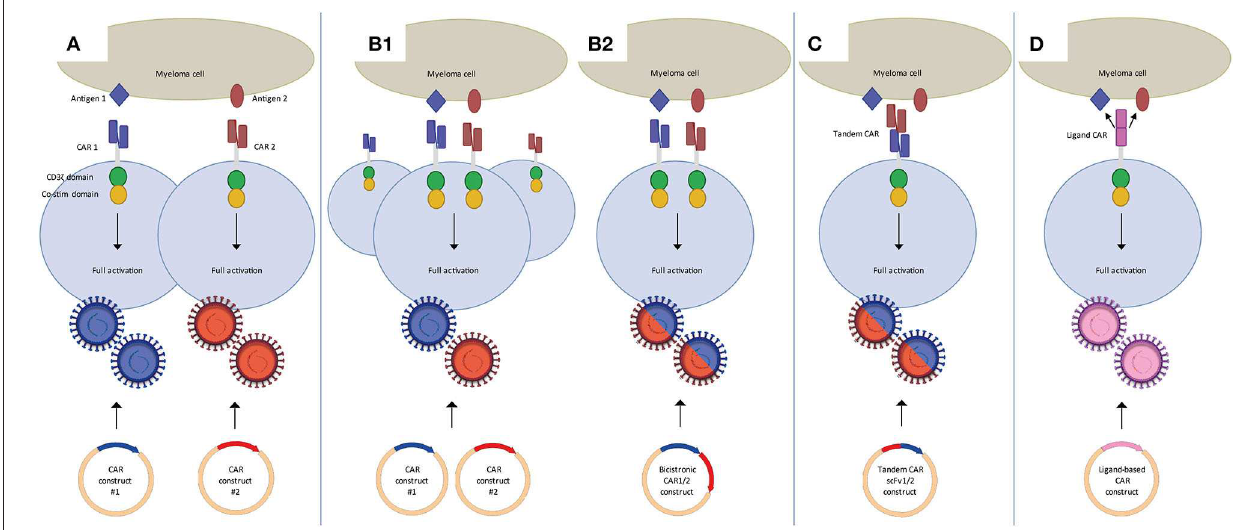
FIGURE 1 | Dual CAR strategies to improve efficacy of CAR T-cell MM therapy. (A) Mixture of two pools of single CAR T-cells in which each pool targets a different antigen. These can be co-infused or sequentially infused into a patient. (B) Two CARs targeting distinct antigens expressed on one T-cell through the use of co-transduction (B1) or a bicistronic vector (B2) . Binding of either one of the CARs is sufficient to activate the T-cell. (C) Tandem CAR T-cells, which contain two distinct binding domains linked to one receptor. Binding of either one of the domains is sufficient to activate the T-cell. (D) Ligand-based CAR T-cells, containing a ligand as binding domain that can recognize more than one antigen. Binding of either one of the antigens is sufficient to activate the T-cell.